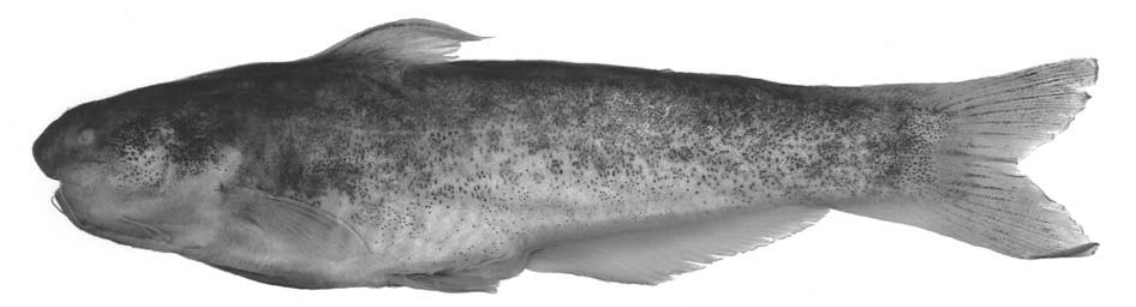
Fig. 37. Cetopsis plumbea, MUSM 11689, 64.1 mm SL; Peru, Puno, Carabaya, río Explanada, Zona Reservada Tambopata- Candamo (13°24’S,